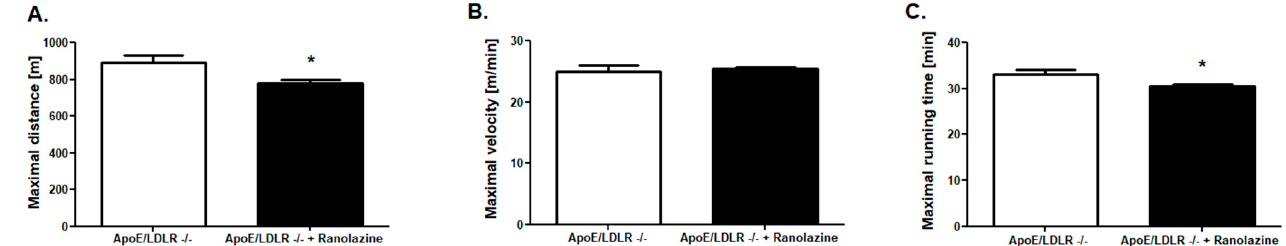
Figure 8. Increased exercise capacity in ApoE/LDLR -/- mice was blunted by Ranolazine (inhibitor of free fatty acids oxidation). Maximal distance ( A ), velocity ( B ), and running time ( C ) in incremental strenuous running test in ApoE/LDLR -/- and ApoE/LDLR -/- Ranolazine treated mice. Results presented as mean ± SEM, n = 10, * p < 0.05.